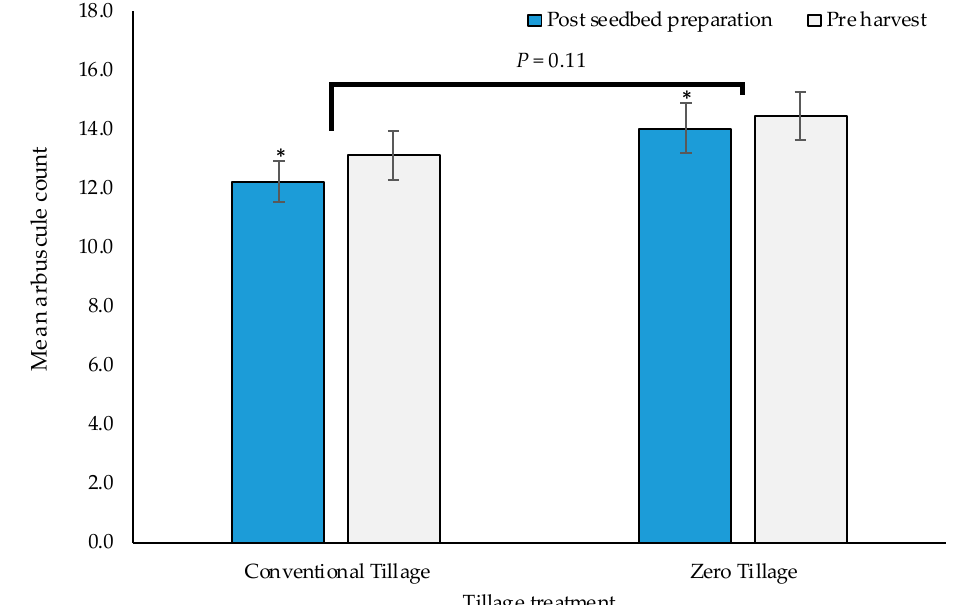
Figure 2. Average ( n = 20 per sampling period per tillage treatment) stained intracellular arbuscular mycorrhizal (AM) fungal arbuscules post seedbed preparation and pre-harvest between conventional and zero tillage managed soils growing winter wheat. Multi-way ANOVA: F = 2.60,3 y = 19; P = 0.11); (*) post-hoc t -test ( F = 83.89,1 y = 19; P = 0.01). Error bars = Standard Error of Mean (SEM).